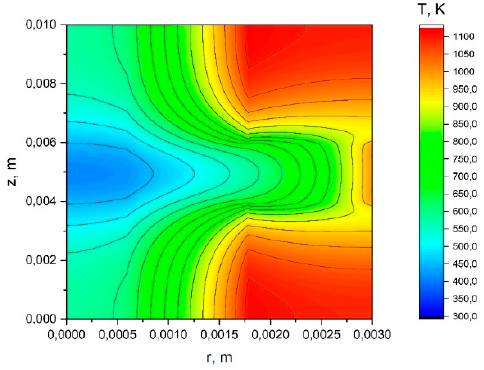
( a ) ( b ) Figure A27. Temperature distribution in the stem of a herbaceous plant: R = 0.003 m, t = 6 s, q = 0.5 kW/m 2 ( a ); R = 0.003 m, t = 6 s, q = 3 kW/m 2 ( b ).